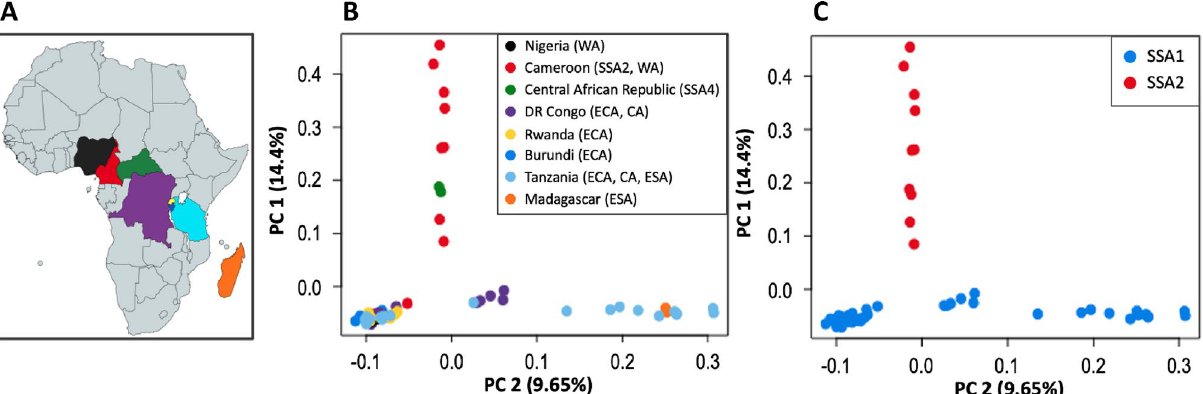
Figure 1. Sampling sites and principal component analysis of SSA Bemisia samples. Principal component analysis (PCA) was based on 14,358 genome-wide SNPs across the 62 sub-Saharan African cassava Bemisia samples from eight sub-Saharan countries. ( A ) African countries where whitefly individuals were sampled from. Country names and colours as ( B ). African map created using mapchart <mapchart.net>. ( B ) Country of origins for these SSA1 and SSA2 Bemisia species are shown by unique colour codes. Parentheses after country names are the ‘genetic groups’ as proposed by Wosula et al. 38 . ( C ) PCA showing clustering of individuals by